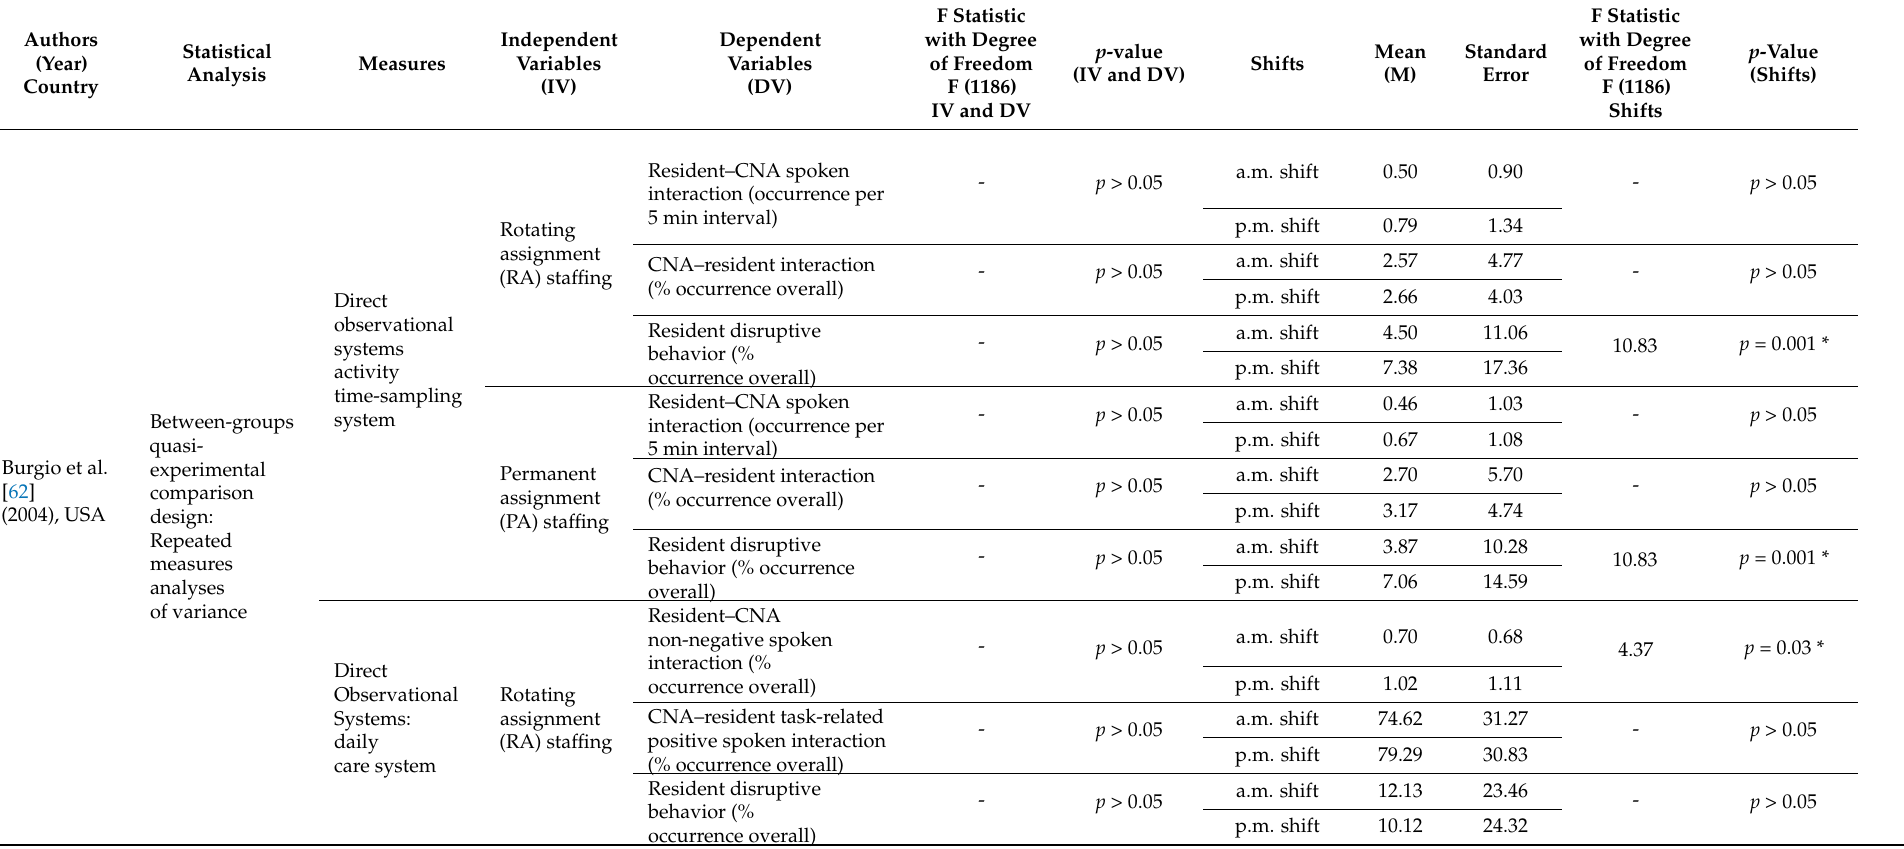
Table 5. Statistical results from the quasi-experimental